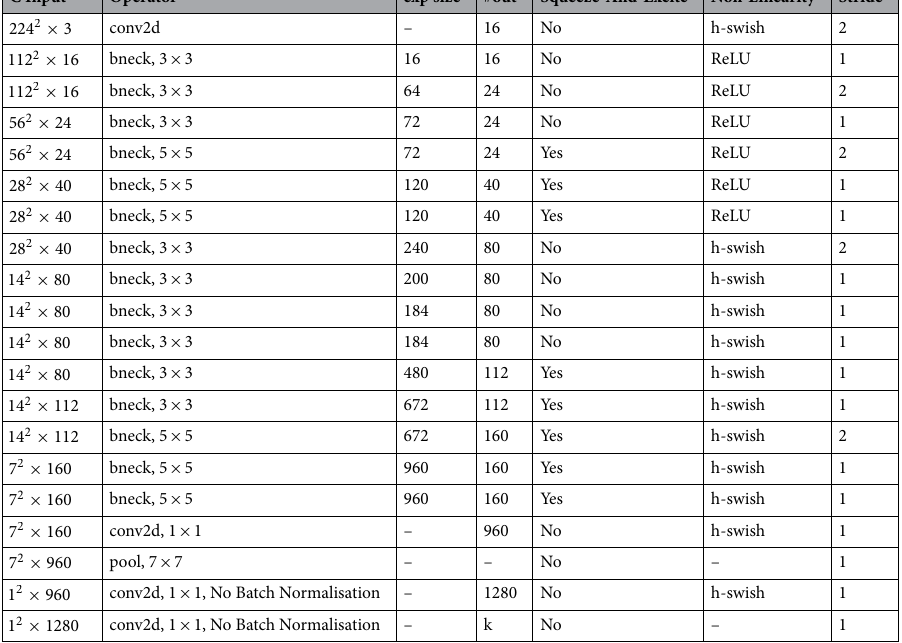
Table 2. Specifications of